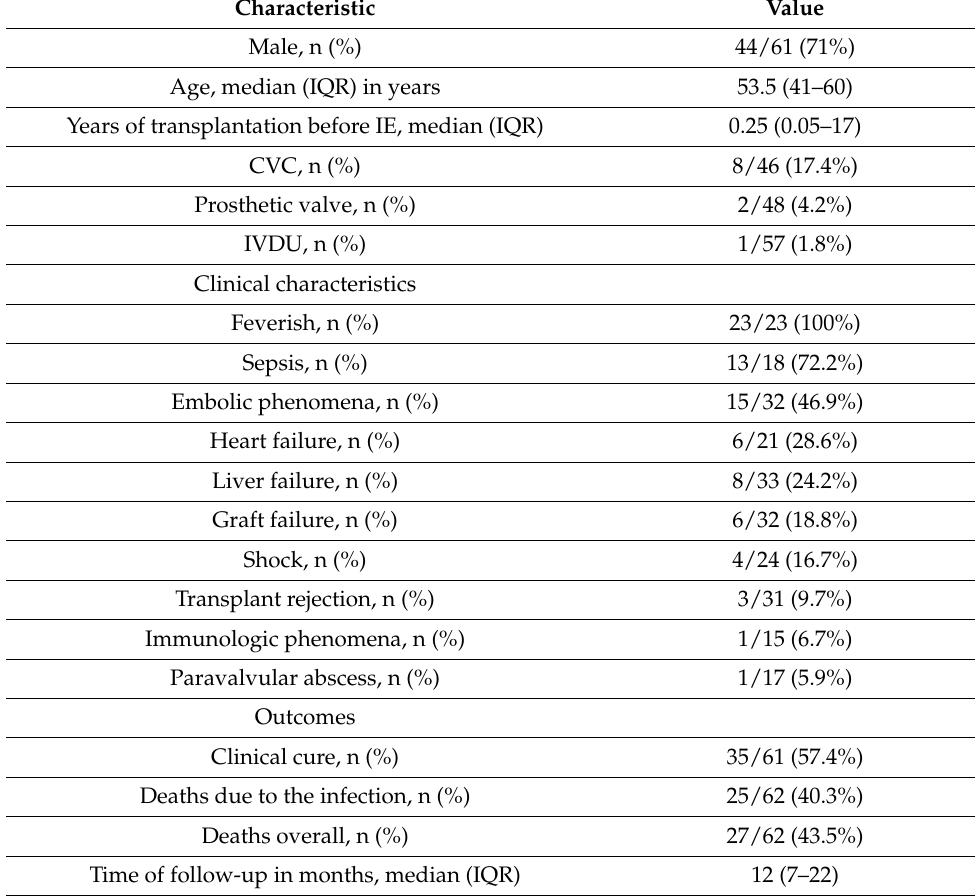
Table 1. Characteristics of 62 patients with liver transplantation and Infective Endocarditis. Values show cases among patients with available